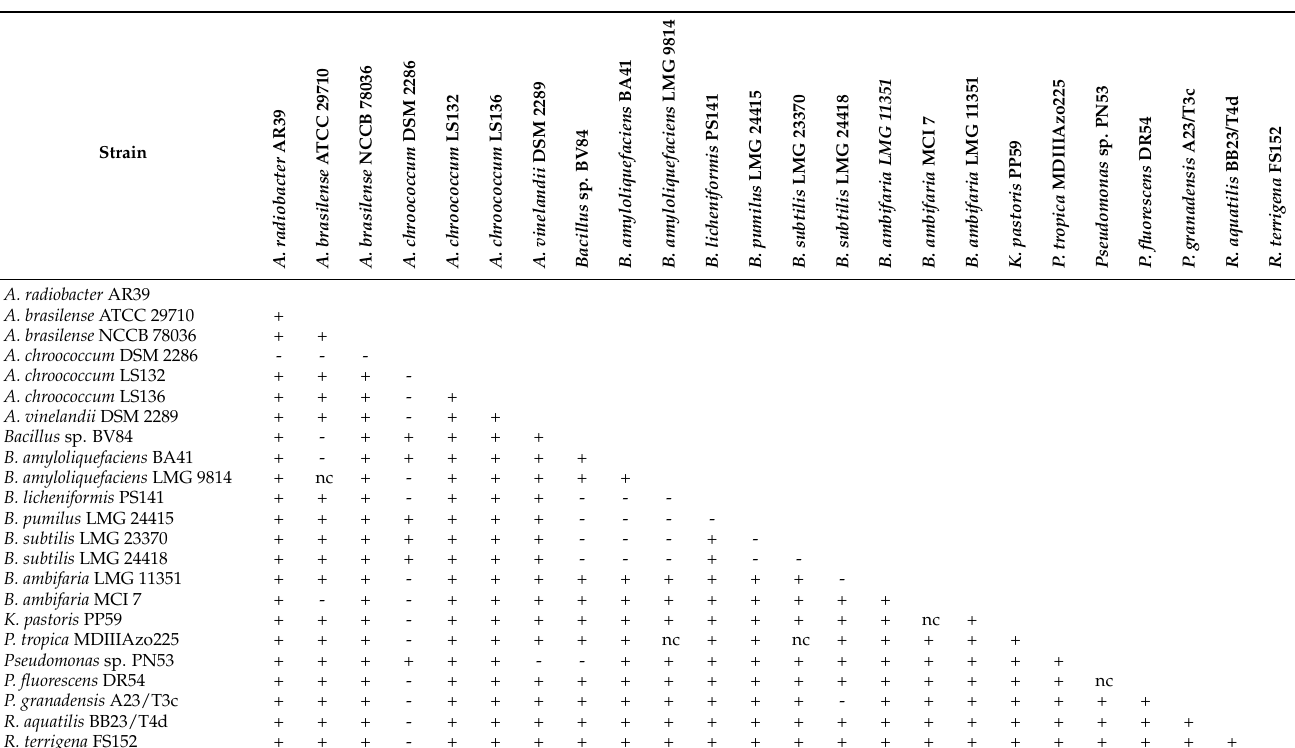
Table 3. Pairwise Compatibility among Bacterial Strains and between Each Bacterium and the Yeast K. pastoris PP59 Using the Modified Agar Diffusion Method in Nutrient Agar (NA) Plates.